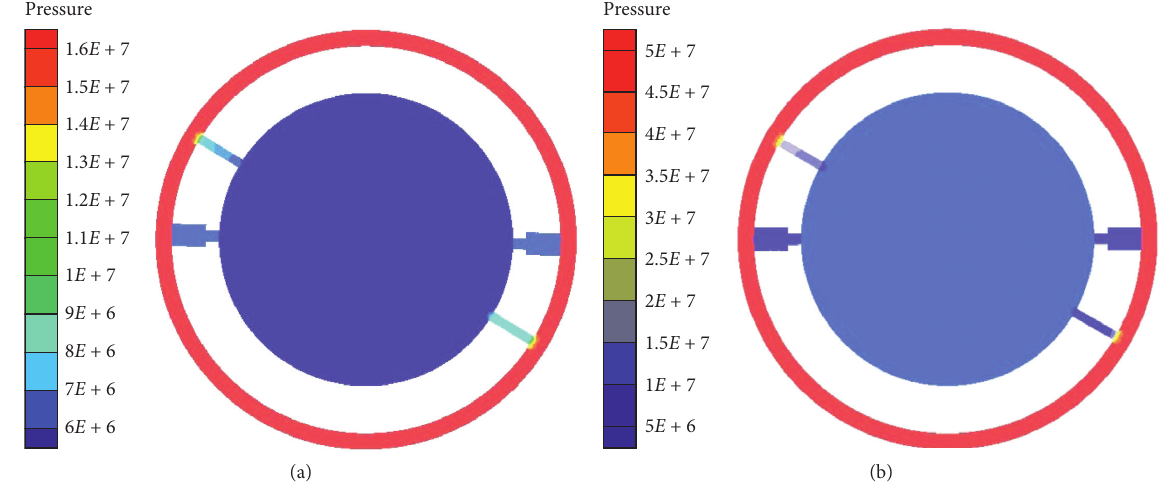
Figure 11: Pressure distribution contours at a cross-section of the damping valve in extension stroke at (a) t � 0.05s and (b) t �